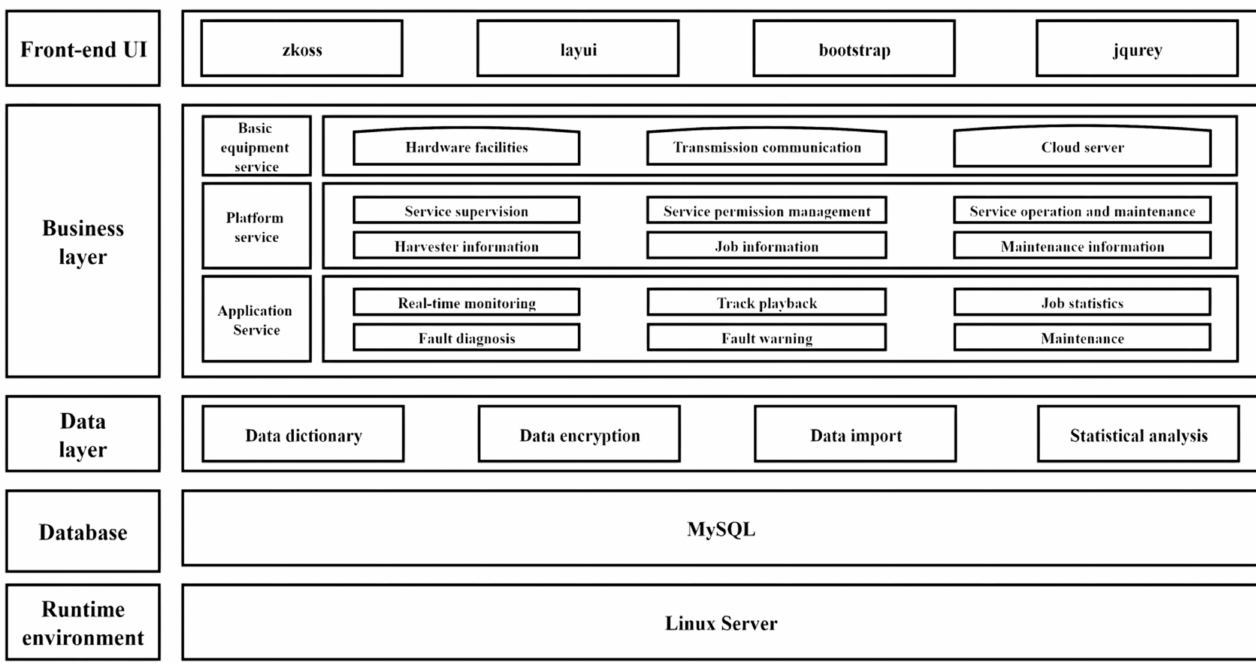
Figure 2. Overall architecture of platform.